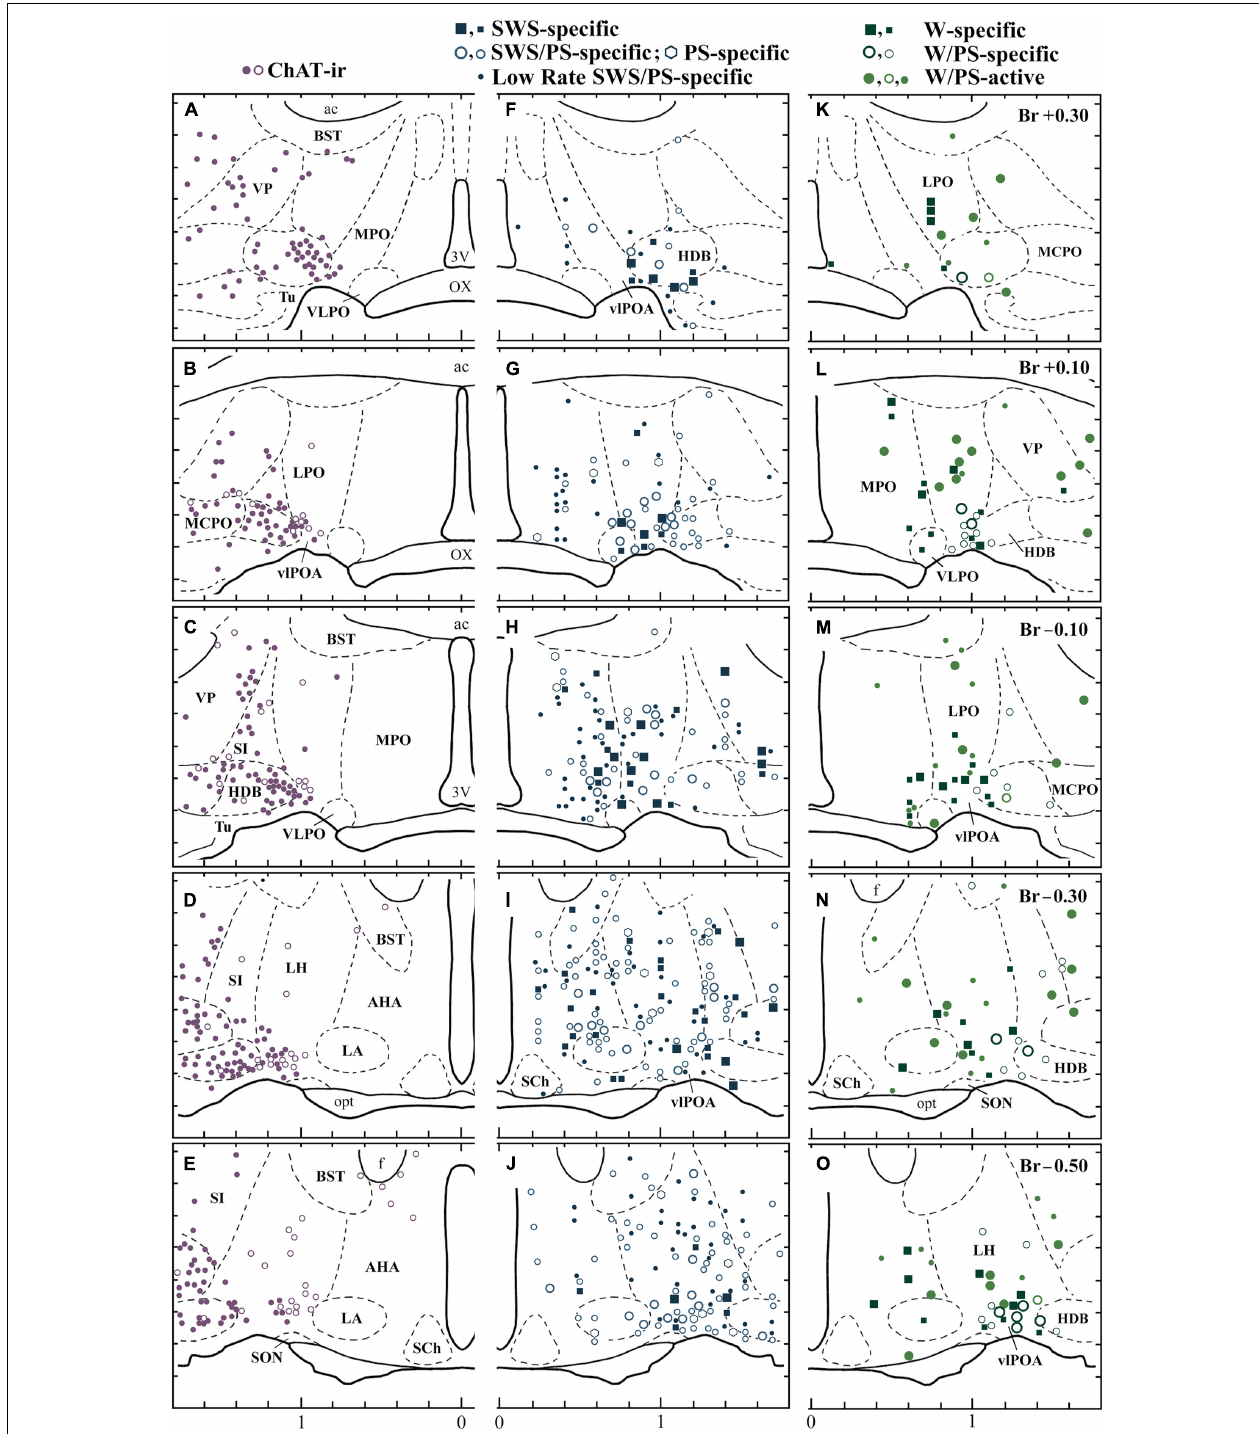
FIGURE 3 | Distribution of sleep-active and wake-active neurons in the POA. Camera lucida drawings of frontal sections (five different planes at 0.2 mm intervals rostral to caudal). (A–E) Distribution of ChAT-immunoreactive neurons (dots and circles). (F–J) The four groups of sleep-active neurons (squares, circles, circles with a central dot, and dots). (K–O) Distribution of waking-specific (squares), waking/PS-specific (circles), and waking/PS-active (dots and thick-lined circles) neurons. The dots and circles in (A–E) indicate heavily and faintly stained ChAT-immunoreactive neurons, respectively. The large and small symbols indicate rapidly firing (fast) and slowly firing (slow) neurons, respectively. The thick-lined circles in (K,M,O) indicate W/PS-active neurons discharging in close relation to theta waves. 3V, third ventricle; ac, anterior commissure; BST, bed nucleus of the stria terminalis; f, fornix; LA, lateroanterior hypothalamic nucleus; opt, optic tract; OX, optic